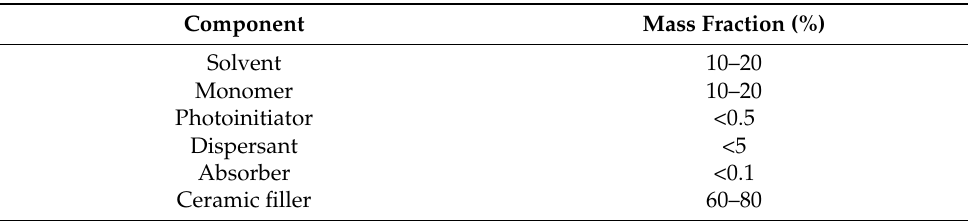
Table 1. Typical formulation for a photo-reactive suspension used in lithography-based ceramic manufacturing